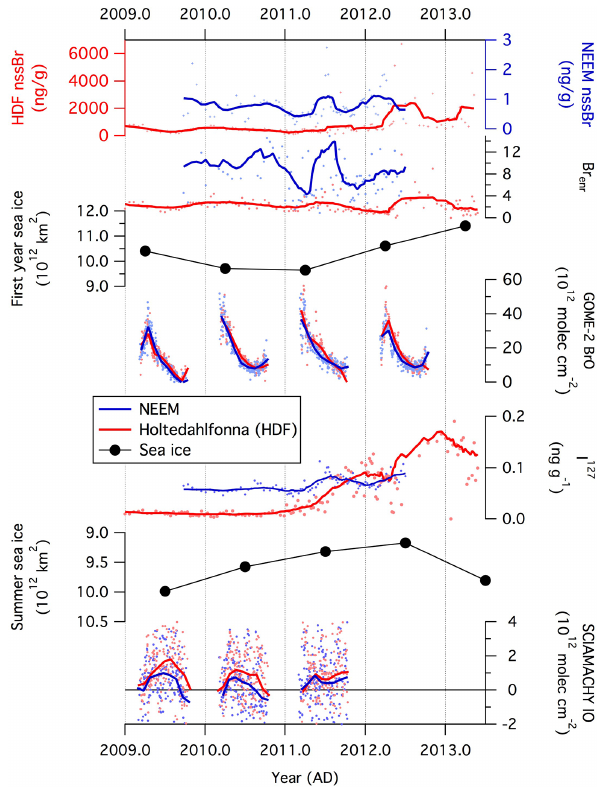
Figure 5. Halogens in the Arctic atmosphere and surface snow compared to sea ice parameters from 2009 to 2013. For all data series, measurements corresponding to the NEEM site (northwest Greenland) are shown in blue, whereas measurements correspond- ing to Holtedahlfonna (HDF, Svalbard) are shown in red. The top half of the figure relates to bromine and the lower half to iodine. Bromine enrichment (Br enr , calculated relative to seawater Br/Na mass values), non-sea salt bromine (nssBr) and iodine concentra- tions determined in surface snow from NEEM and HDF are shown as individual data (points) and 15-point moving averages (lines). First-year sea ice is defined as the difference between the March maximum and the preceding September minimum of Arctic sea ice extent. Summer sea ice (note reversed scale) is defined as the av- erage sea ice extent between May and August. Daily (points) and monthly (lines) atmospheric column amounts of BrO and IO de- rived from satellite data are also shown for